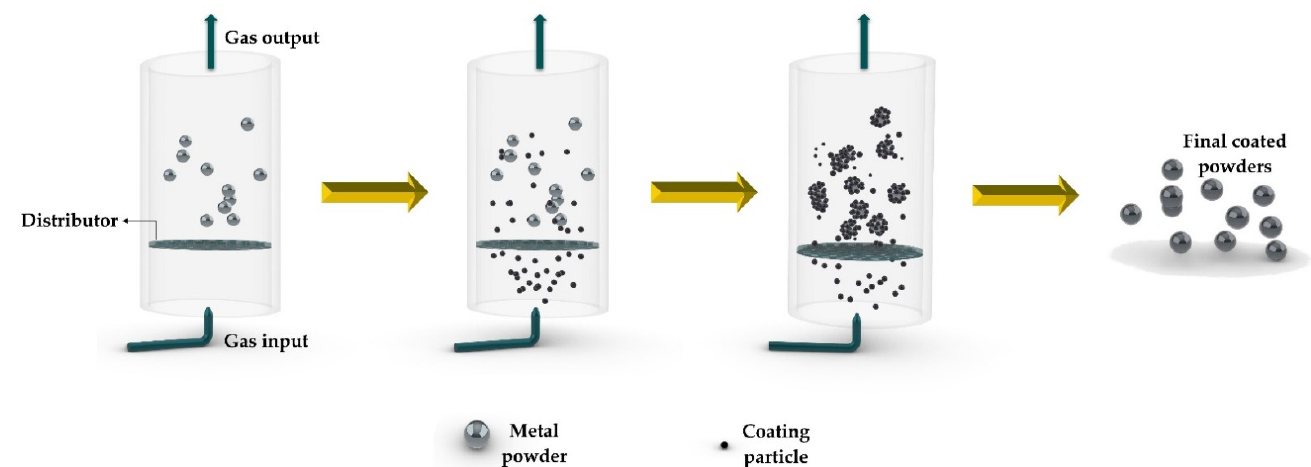
Figure 4. Schematic diagram of FBCVD process for coating powders, the objects in figures are not in scale.